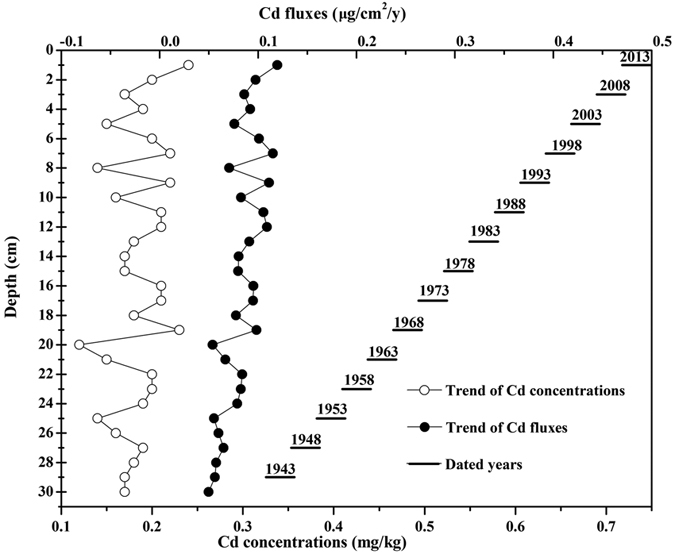
Cd distribution and 210Pb chronology of the sediment core from the outlet area.